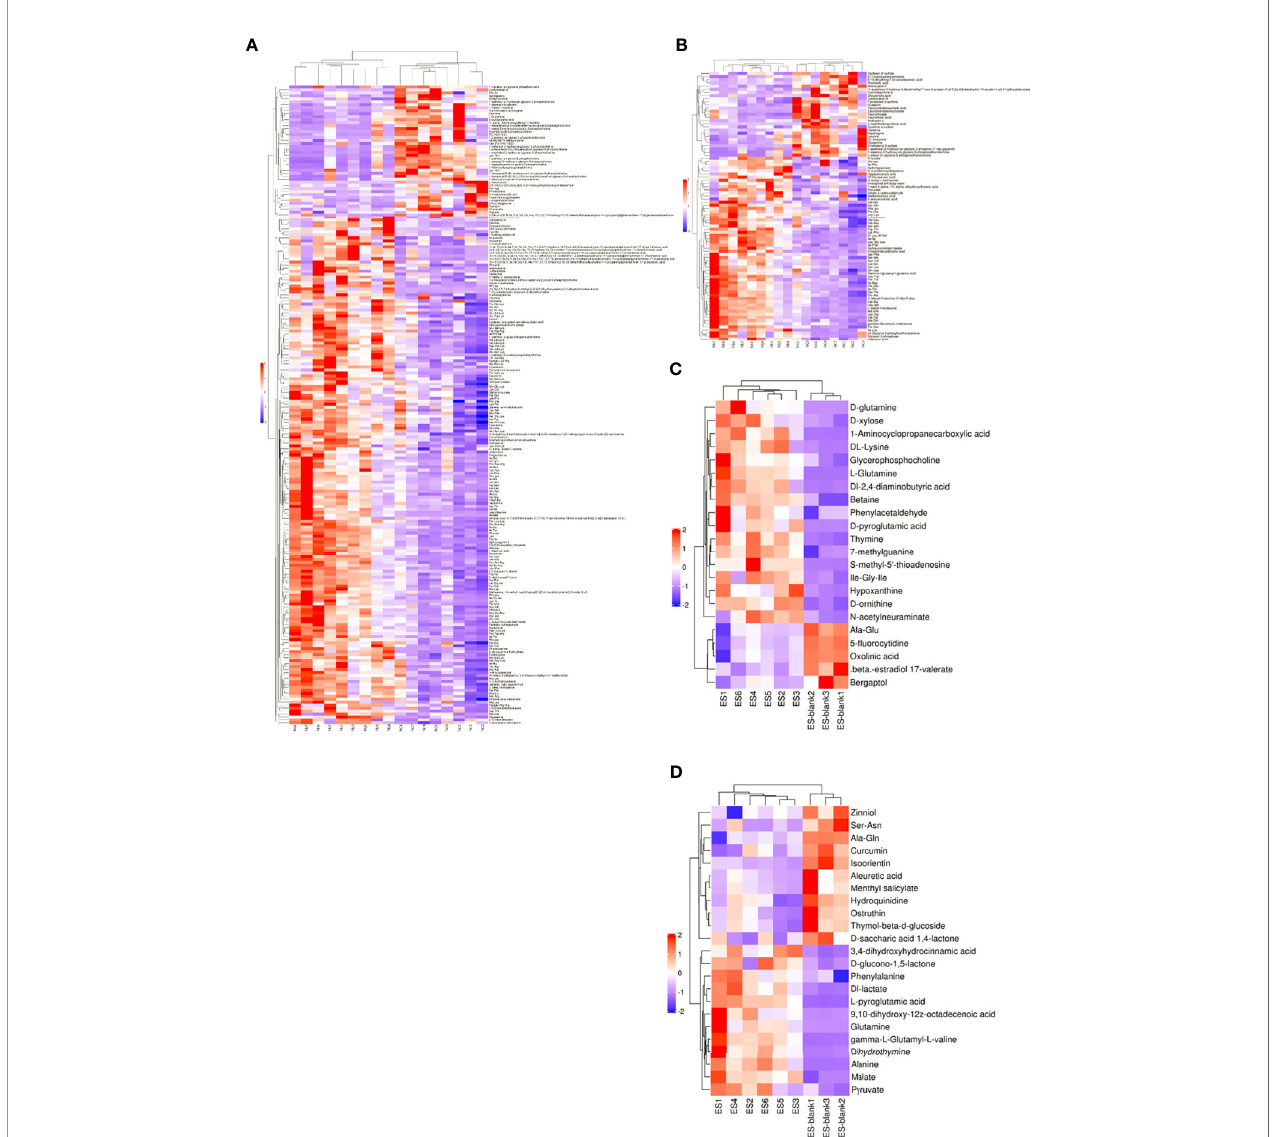
FIGURE 3 | Heatmaps of different metabolites within the Nb and ES groups. (A, C) show the positive ion mode and (B, D) show the negative ion mode. The signi fi cance of metabolite change (red denotes upregulated and blue indicates downregulated) was proportional to the color of each section. Rows correspond to metabolites, while columns correspond to